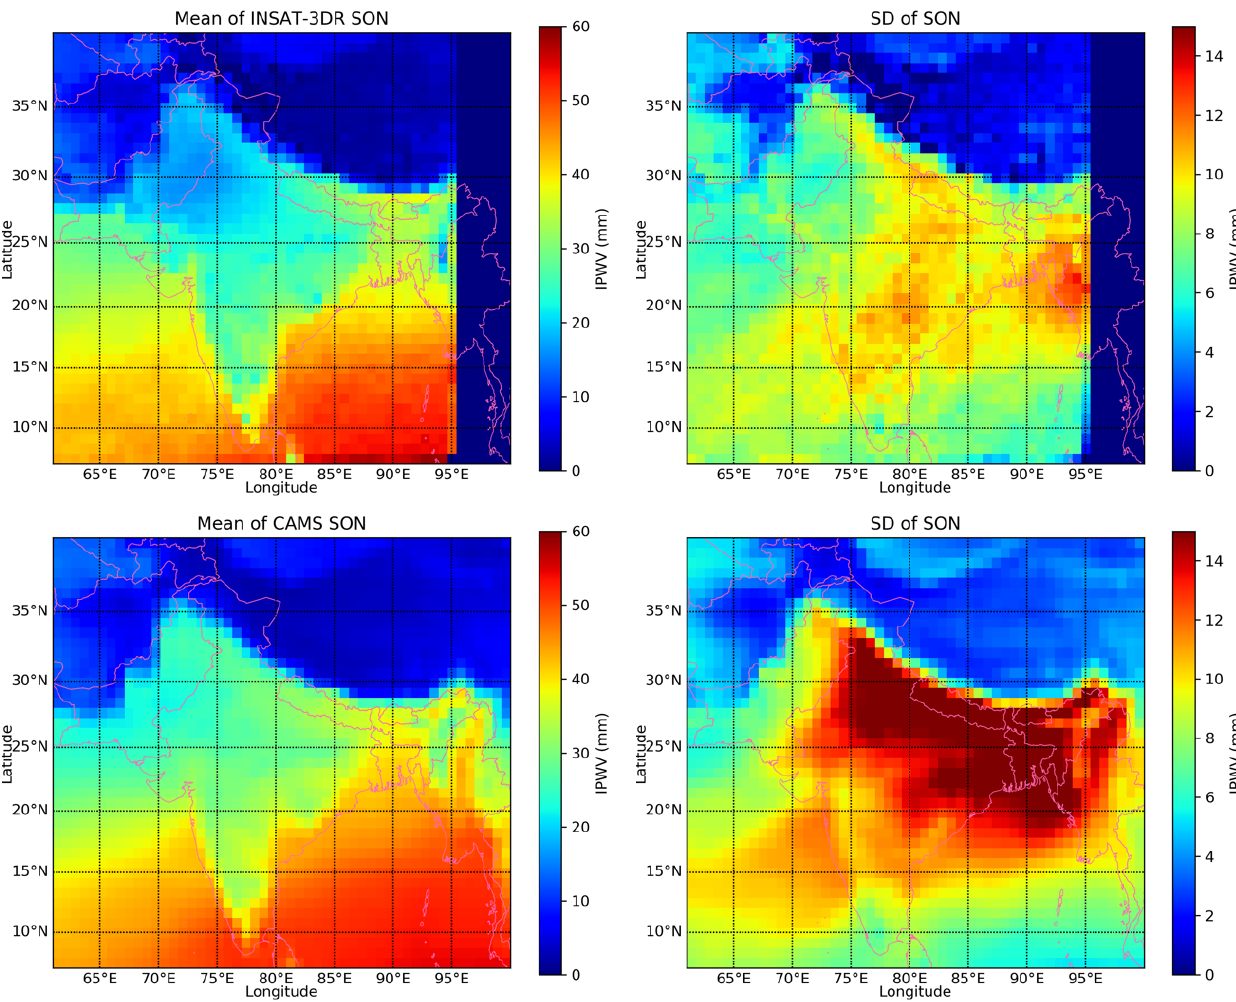
Figure 10. Seasonal means and SDs of INSAT-3DR and CAMS-retrieved IPWV for the year 2018.